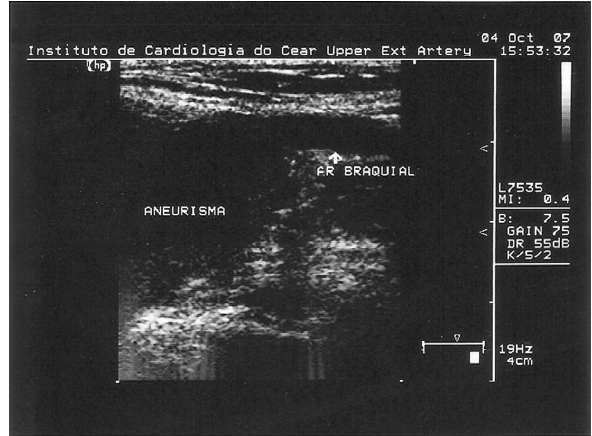
Fig. 1 - Ultrassonografia demonstrando a relação do aneurisma com a artéria braquial